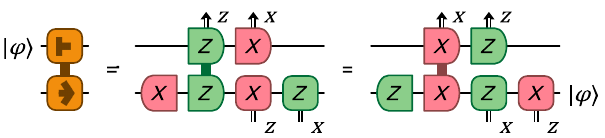
FIG. 16. The move operation can be implemented in depth 1 by local and neighboring Pauli measurements. A horizontal move operation can be implemented by preparing a single-qubit patch in | 0 (cid:4) , applying joint XX measurement, and then measuring the original patch in the Z basis (up to Pauli corrections). The ver- tical move operation follows from applying a Hadamard gate to the source qubit | φ (cid:4) and a Hadamard gate on the output. Simpli- fying the circuit gives the right-hand side in the figure, with a ZZ measurement that is available vertically. FIG. 18. We can implement Bell preparation and measurement